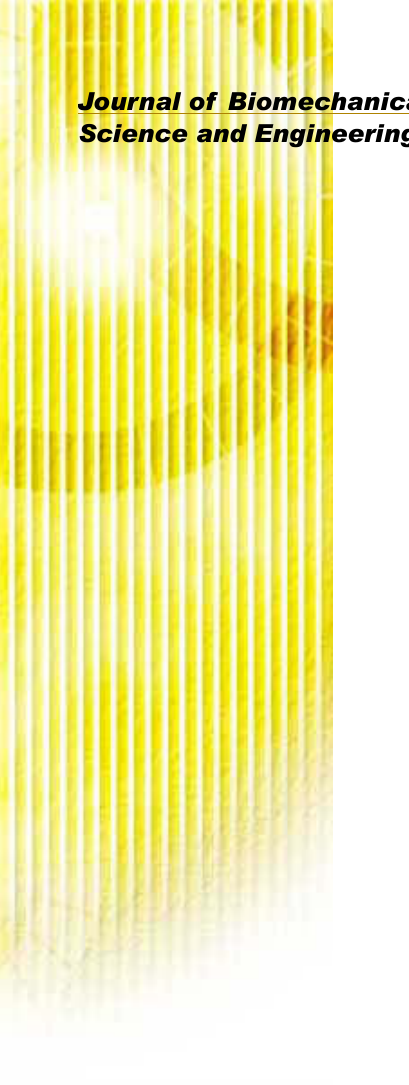
F n : the normal component of knee joint force, which is parallel to the tibial axis F t : the tangential component of knee joint force, F: the net knee joint